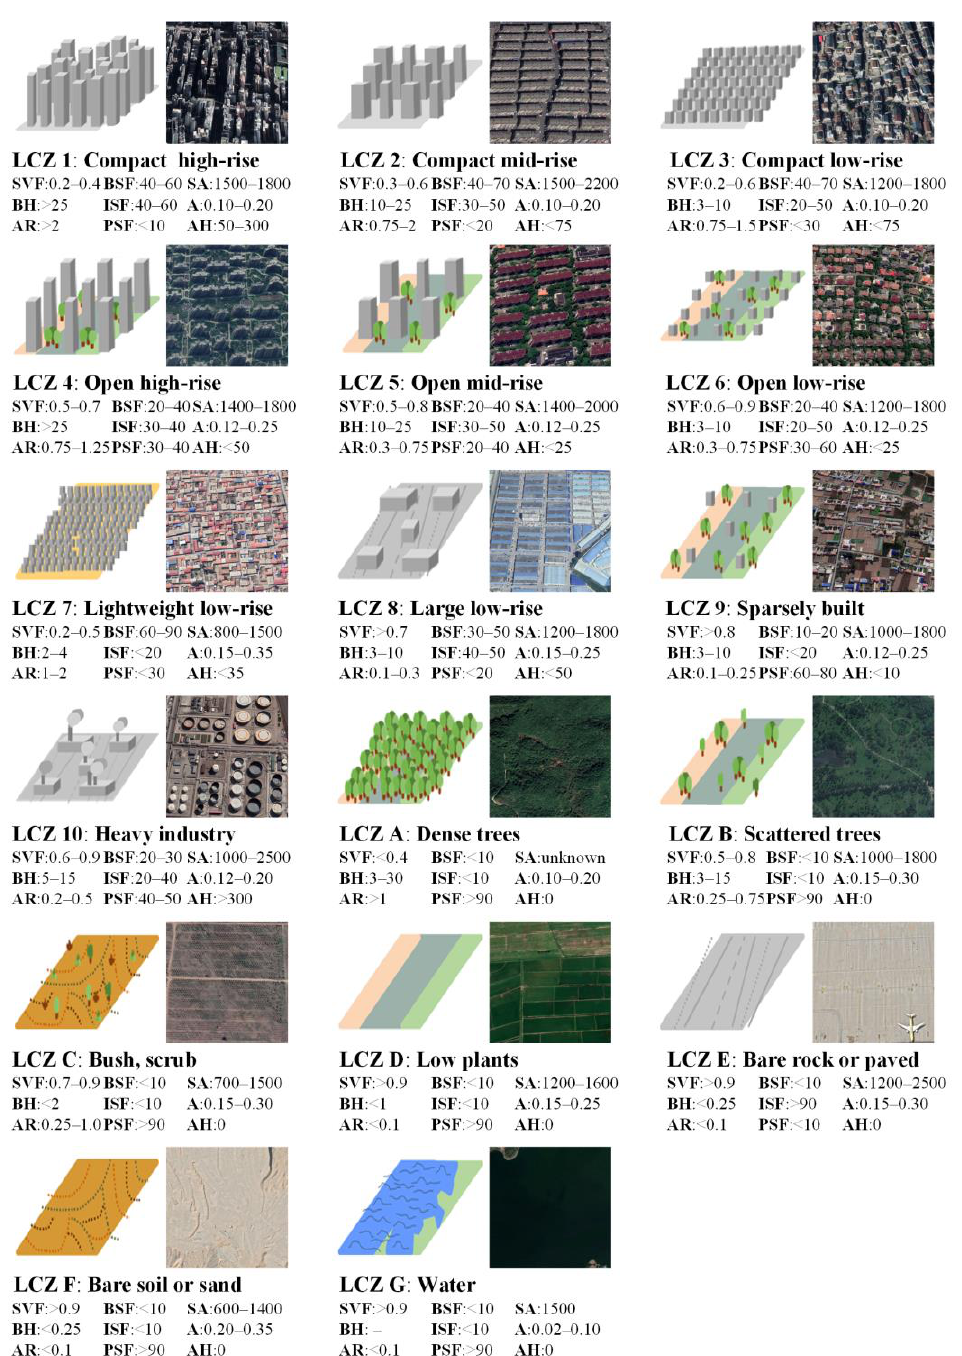
Figure 1. Classification of local climate zones and range of urban canopy parameters based on [11]. (Note: The top-left corner of each LCZ type is the schematic drawings given by [41]. The top-right corner of each LCZ type is the representative high-resolution images from Google Earth. SVF means sky view factor; BSF means building surface fraction; SA means surface admittance; BH means height of roughness elements; ISF means impervious surface fraction; A means surface albedo; AR means aspect ratio; PSF means pervious surface fraction; AH means anthropogenic heat.).